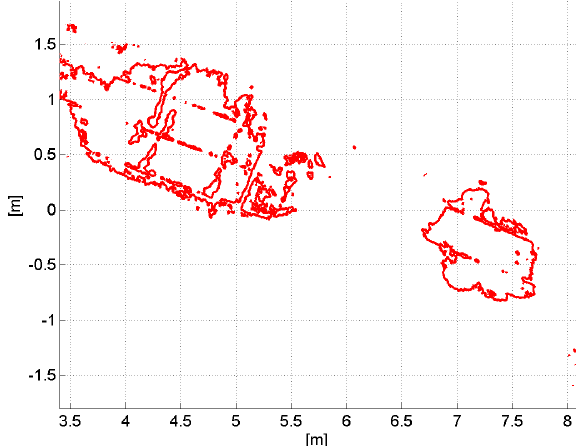
Figure 10: Example of segmentation results: boundaries of de- tected degradation areas of Fig. 7 remapped in the 3D space (in order to improve the readability of the figure, x points are shown instead of M ∗ ).